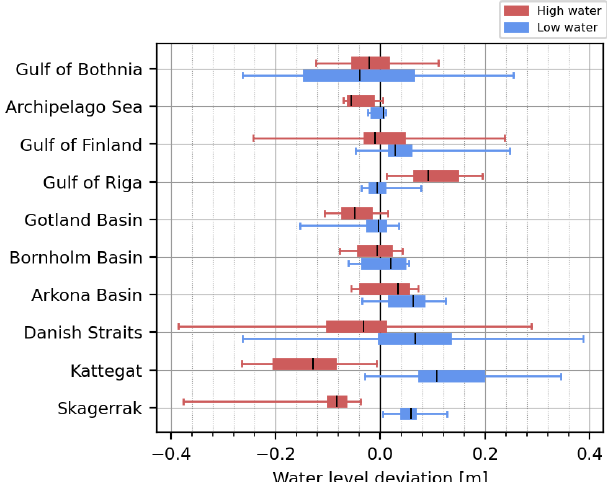
Figure 14. Model deviation in extreme water level cases in different sub-basins. Red and blue bars indicate the model’s deviation from the observed SSH maximum and minimum, respectively. Positive values mean that the modeled SSH is higher. The thin line denotes the entire deviation range; thick bars indicate the 25th to 75th per- centile range. The black line denotes the mean. The sub-basins are defined as in Fig.